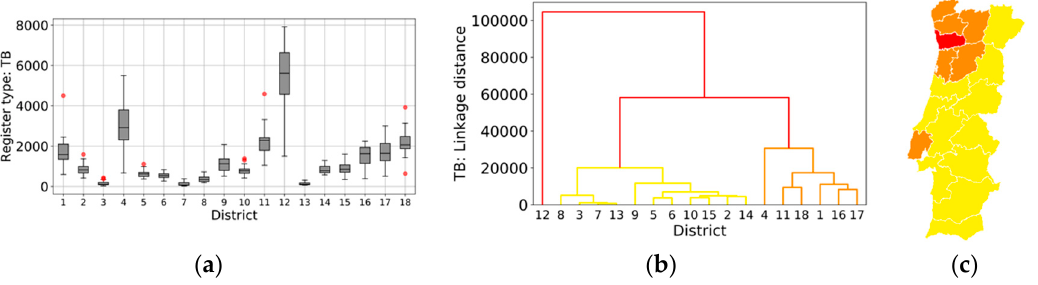
Figure 4. Spatial distribution of Total burns (TB: ( a ) Distribution by district; ( b ) Clusters by annual profile of distribution; ( c ) Clusters in geographic location (cophenetic coefficient: 0.87).